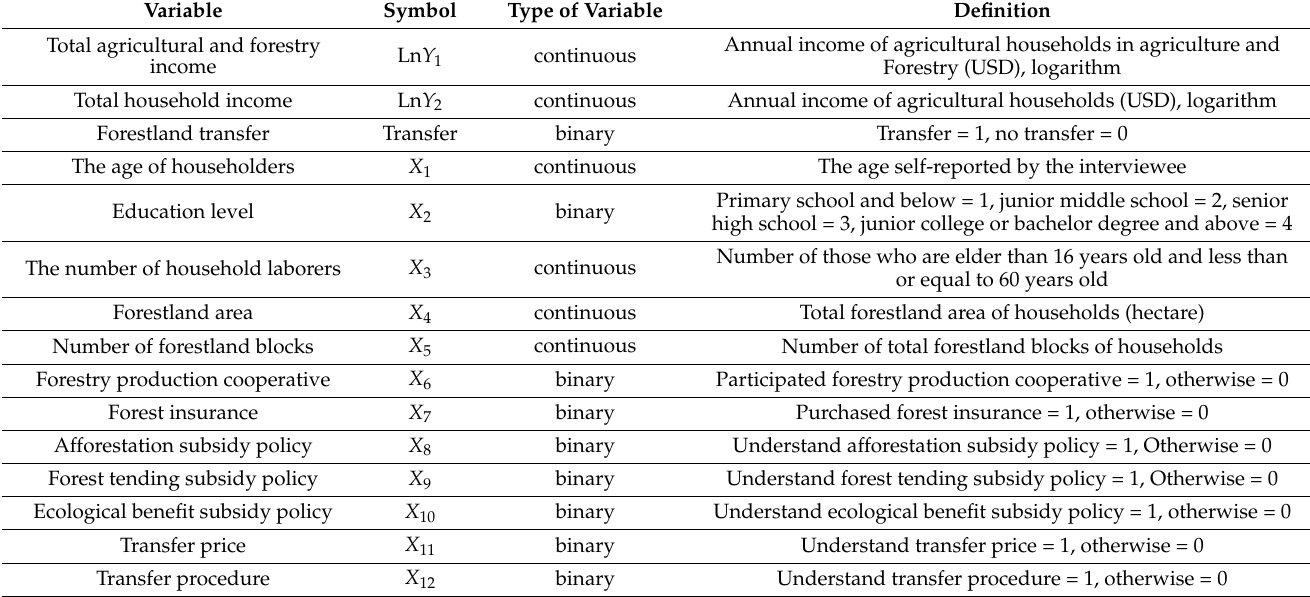
Table 1. Description of all variables in the